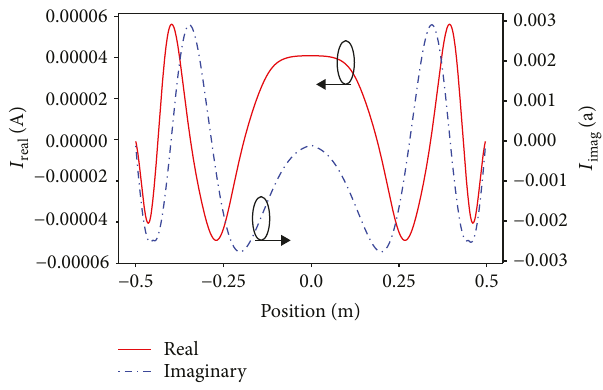
Figure 11: The current distribution along the spiral.